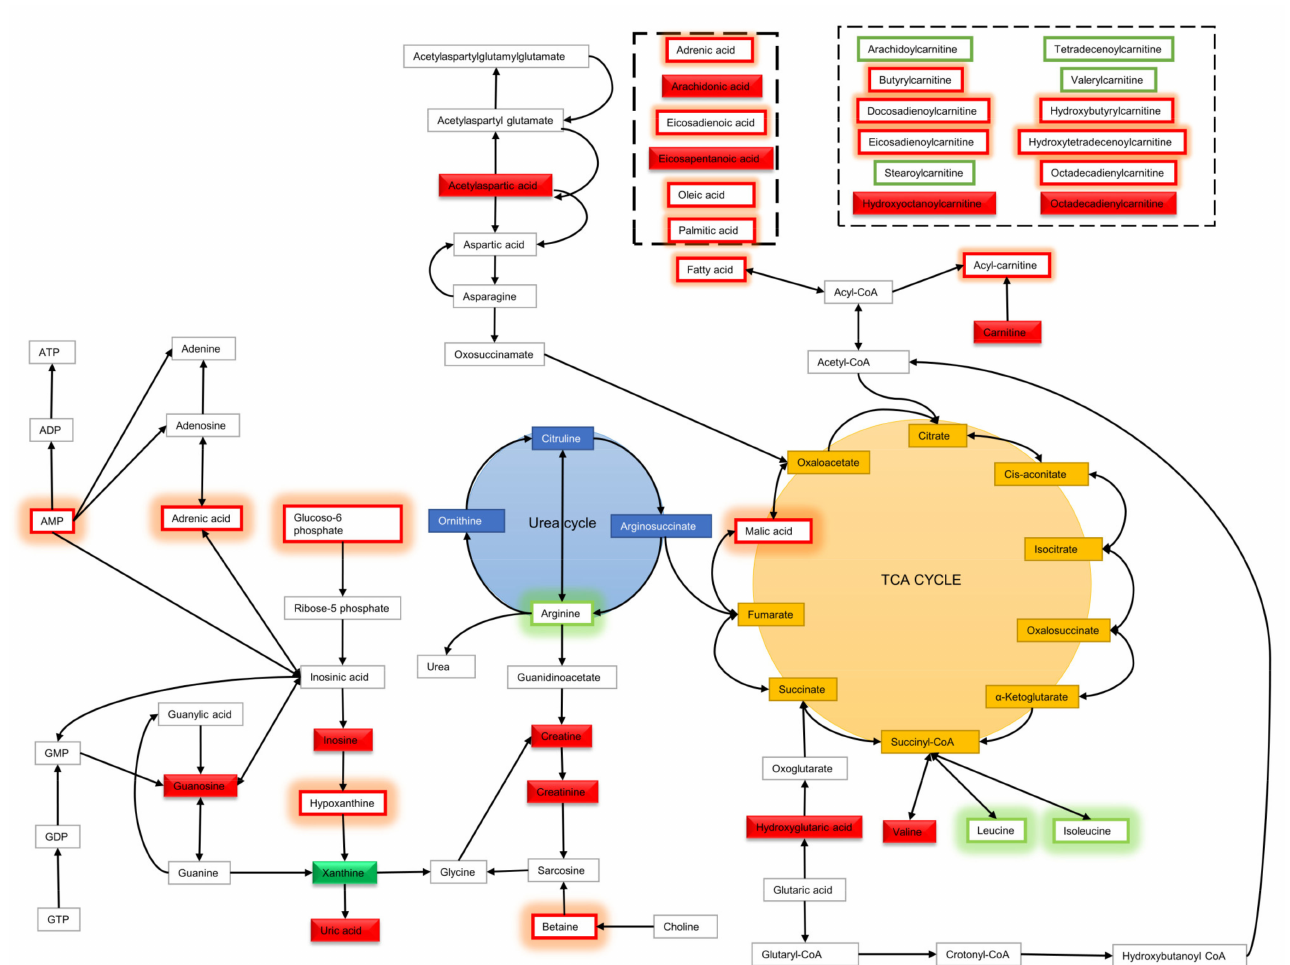
Figure 3. Summary of metabolic pathways which include metabolites discriminating early stages SCC and ADC tissue. Red rectangle—significant metabolites with a decreased percent of change in SCC vs. ADC comparison. Green rectangle— significant metabolites with an increased percent of change in SCC vs. ADC comparison. Red box—non-significant metabolites with a decreased percentage of change in the SCC vs. ADC comparison. Green box–non-significant metabolites with an increased percentage of change in SCC vs. ADC